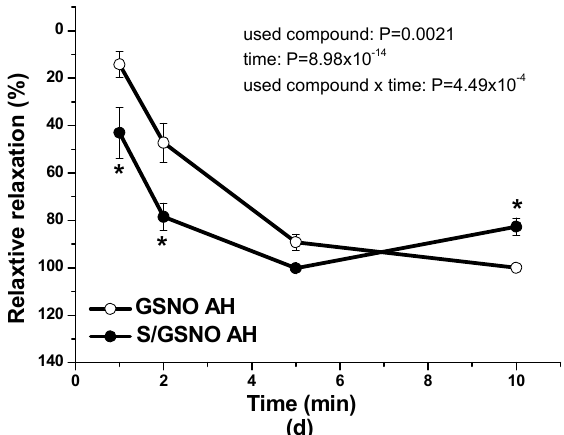
Figure 4. The comparison of vasorelaxations of human lobar arteries induced by GSNO (0.5 µmol/L) and by the S/GSNO products (0.5 µmol/L). The absolute vasorelaxant responses were expressed as a percentage of the serotonin (1 µmol/L)-induced contraction in normotensive patients (NT) ( a ) and in patients with arterial hypertension (AH) ( c ). The relative vasorelaxant responses (revealing the speed of the vasorelaxation) are expressed as a percentage of the maximal relaxation in normotensive patients (NT) ( b ) and in patients with arterial hypertension (AH) ( d ). Results are expressed as the mean ± S.E.M. Significant differences were evaluated by two-way ANOVA for main factors: used compound and time. Bonferroni post hoc test was used to describe the differences in mean values of the experimental groups. * p < 0.05; ** p < 0.01 with respect to the value of the GSNO response within the appropriate graph.